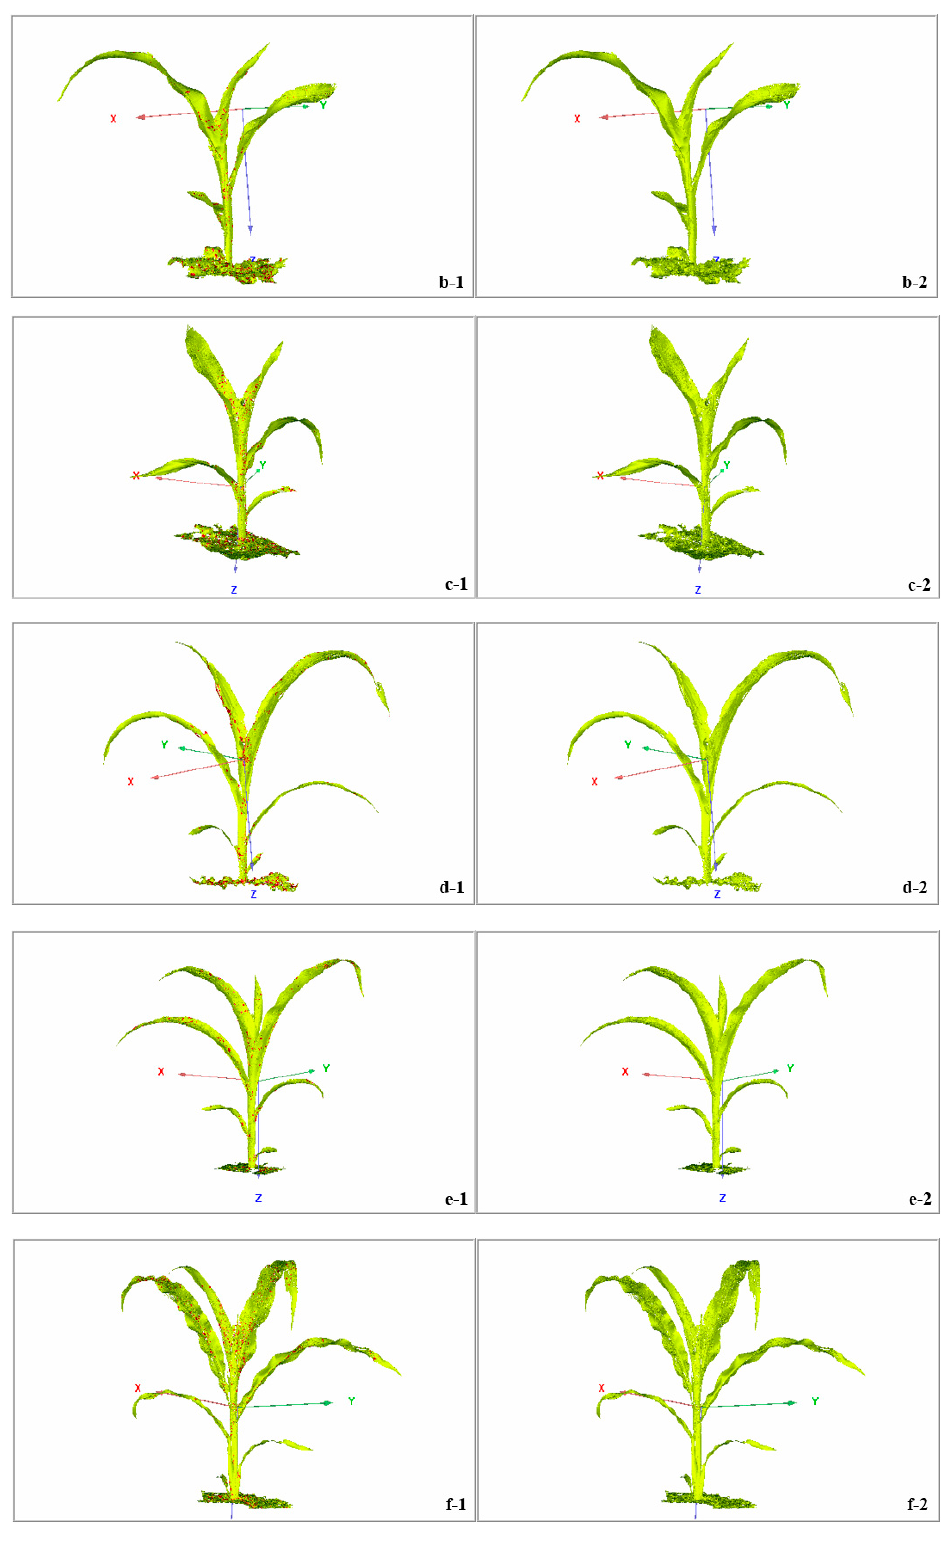
Figure 12. Overall effect of the denoising effect in maize from the trefoil stage to the jointing stage. ( a-